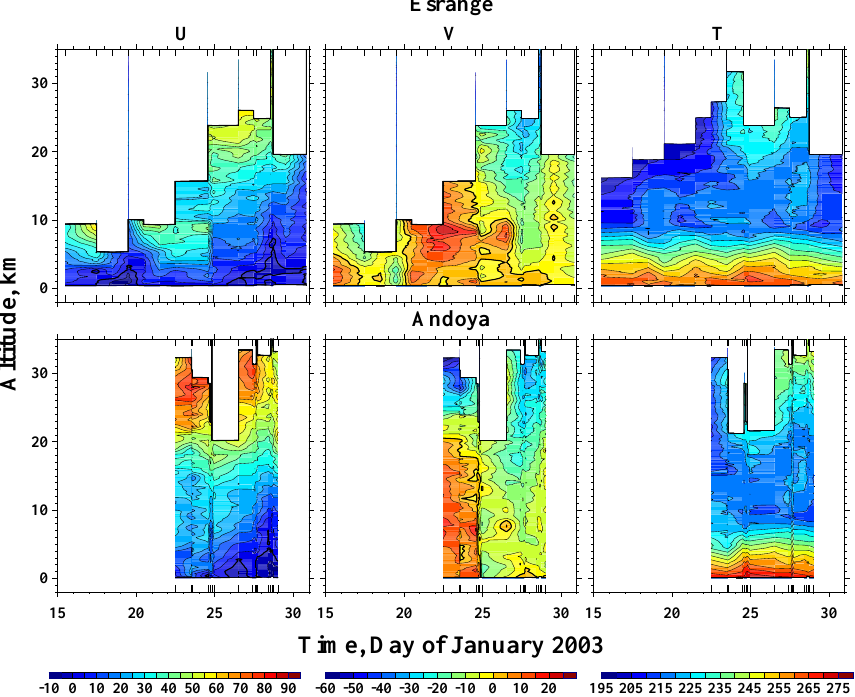
Fig. 2. Time-altitude contours of radiosonde measurements of winds and temperature over Esrange, Sweden (67.9 ◦ N, 21.1 ◦ E) and Andoya, Norway (69.3 ◦ N, 16.0 ◦ E). The contour interval is 10ms − 1 for winds and 10K for temperature. The time coordinates corresponding to individual soundings are marked by the inward ticks. In the abscissa, the outward tick corresponding to each day indicates the beginning of that